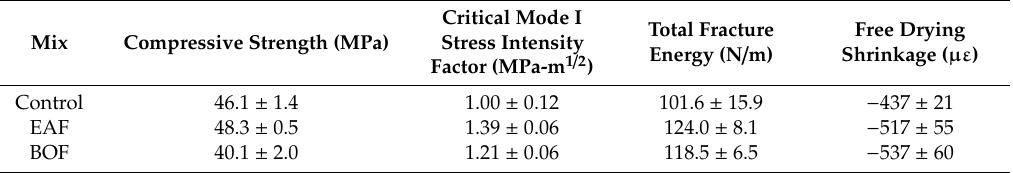
Table 5. Twenty-eight-day concrete properties (average ± standard deviation) for three equivalent mixes with full replacement of coarse aggregate with dolomite (control), EAF slag, or BOF slag [9].